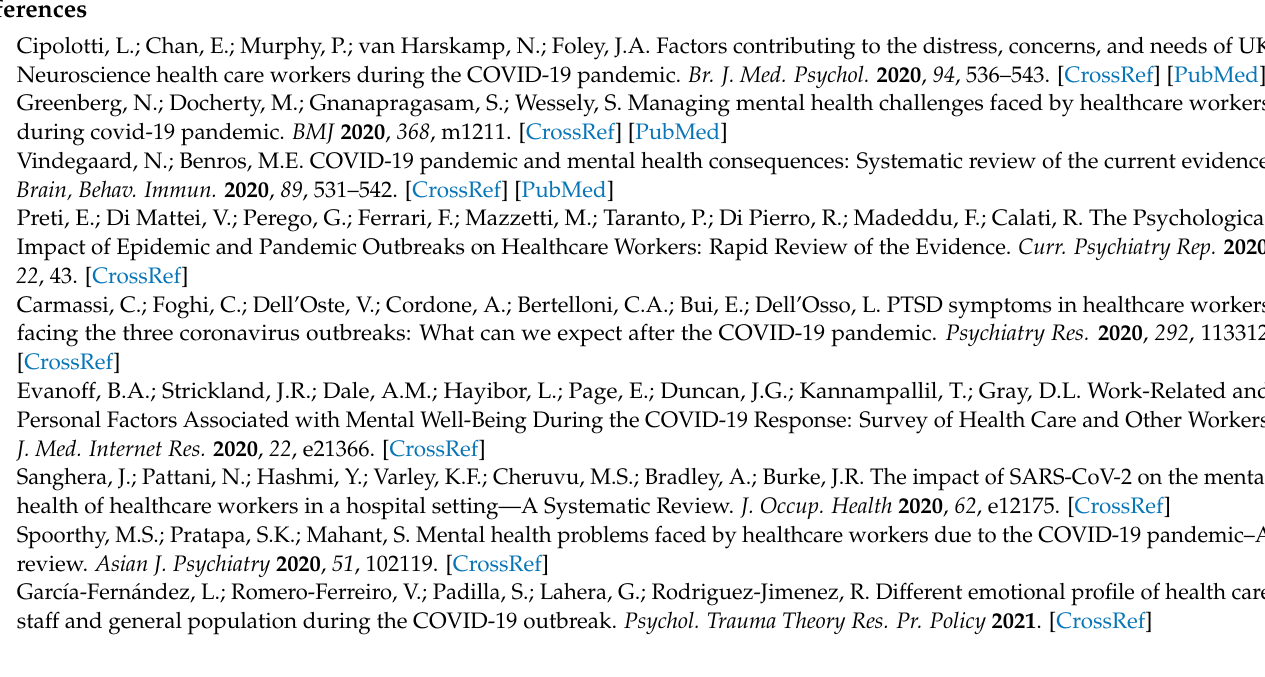
S5: Dunn’s test for IES-R Hyperarousal, Figure S6: Dunn’s test for State-Anger, Figure S7: Dunn’s test for STAXI Verbal Expression, Figure S8: Dunn’s test for STAXI Physical Expression, Figure S9: Dunn’s test for MBI Emotional Exhaustion, Figure S10: Dunn’s test for MBI Depersonalization, Figure S11: Dunn’s test for MBI Personal Accomplishment, Figure S12: Dunn’s test for Working Condition, Figure S13: Dunn’s test for